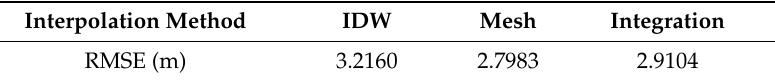
Table 2. Comparison of the accuracy of the DSMs.